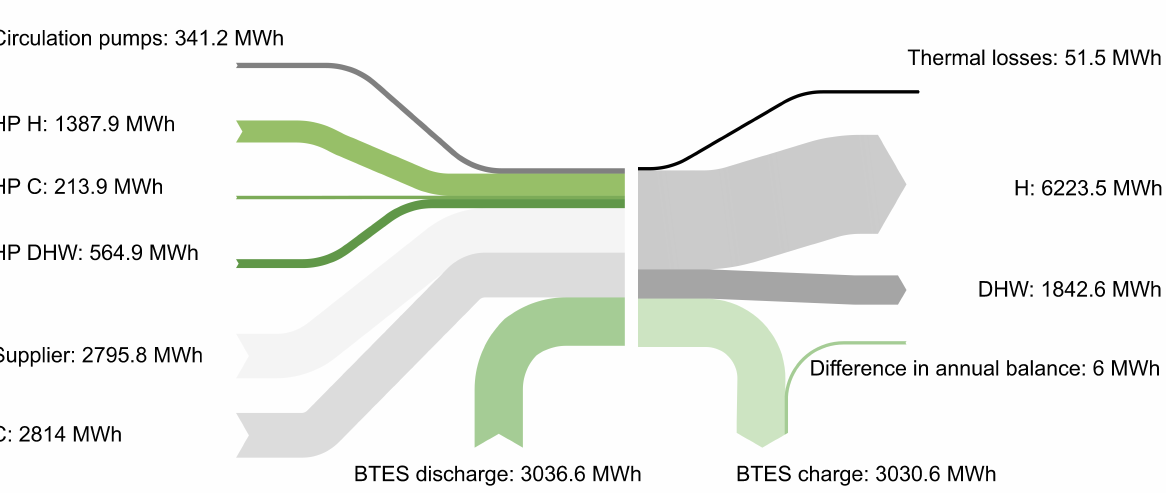
Figure 18. Sankey diagram: Annual energy flows to operate the ULTDH